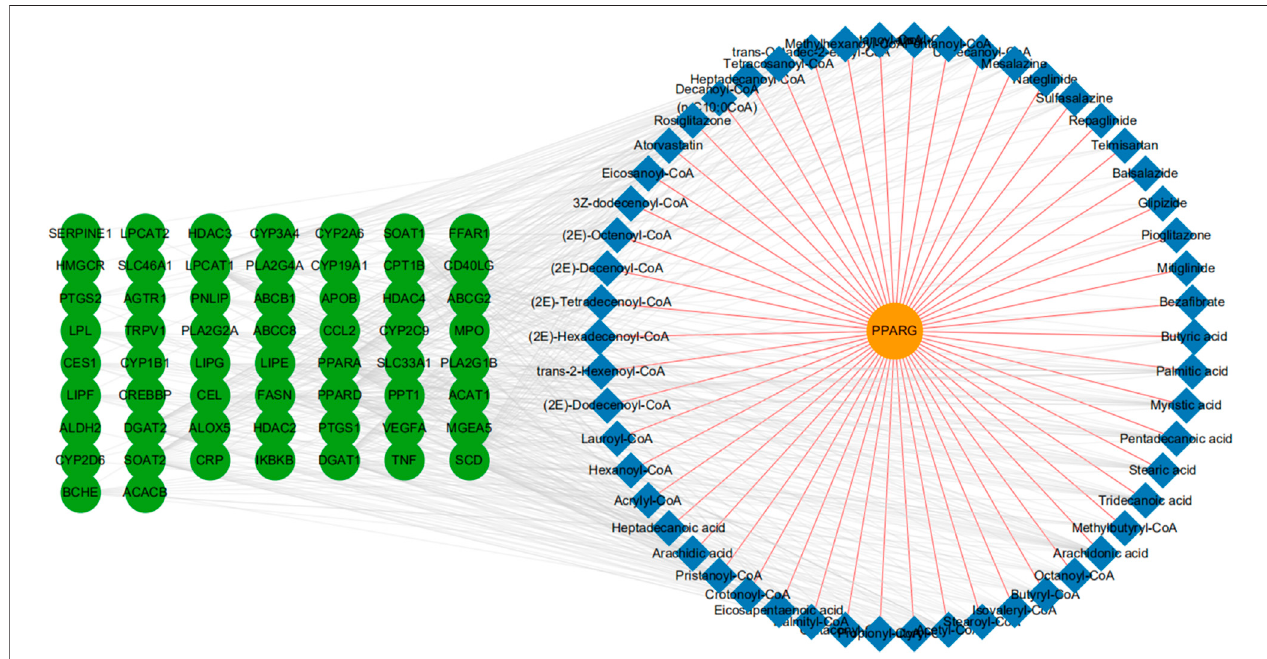
FIGURE1 | Protein-metabolite networkconstruction. A fullnetwork based on the primary protein, PPARG (orangenode), associated metabolites (blue node), and related druggable proteins (green node). We also show PPARG-metabolite interactions (brown-yellow edges), and metabolite-protein interactions (light gray edges).